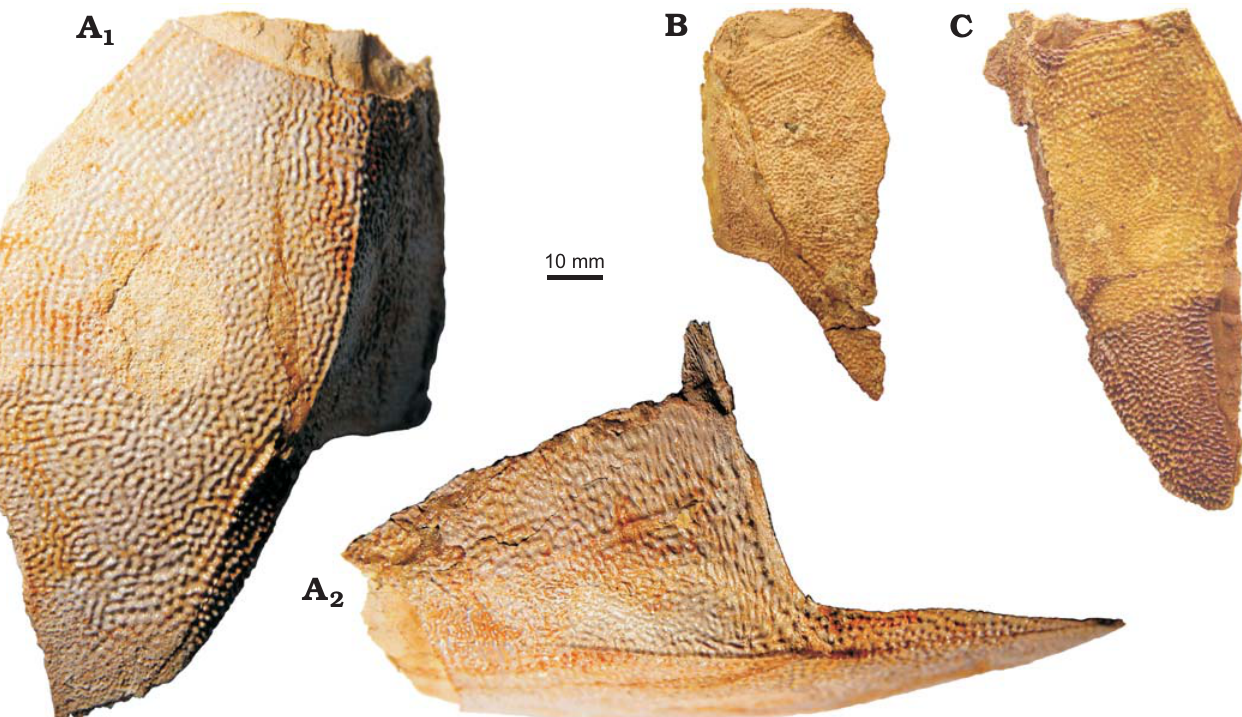
Fig. 12. Antiarchan fish Bothriolepis leptocheira jeremejevi (Rohon, 1900), Sosnogorsk locality, Sosnogorsk Formation, lowermost Famennian, posterior ventro-lateral plates, left (A) and right (B, C) of the trunk armour. A . IG KSC 155/4 in ventral (A 1 ) and lateral (A 2 ) views. B . IG KSC 155/16 in ventral view. C . IG KSC 155/78 in ventral